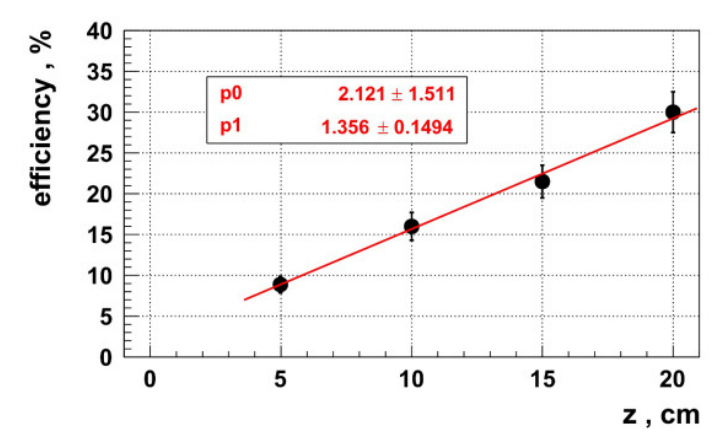
Figure 7. The e ffi ciency of the neutron detector depends on the number of scintillation layers